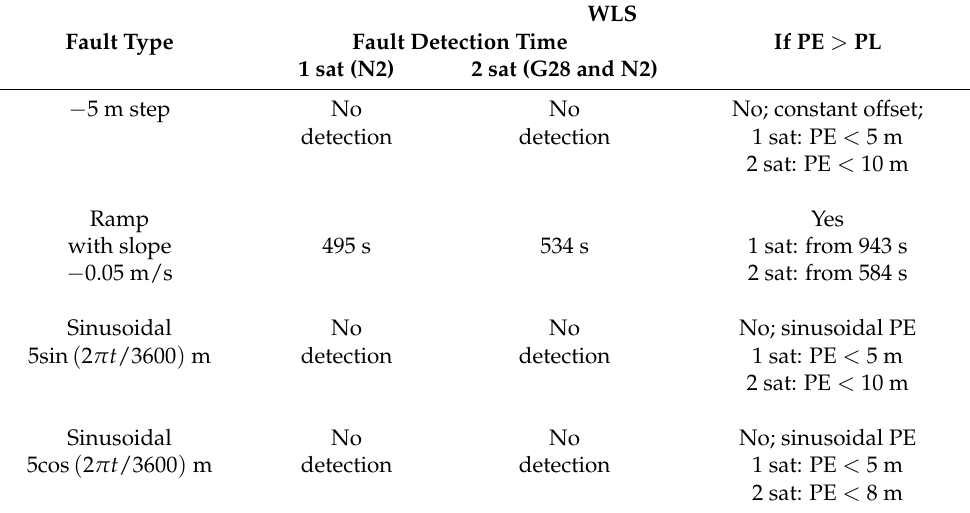
Table 2. Fault detection performance of WLS. Fault detection time is calculated from the beginning of